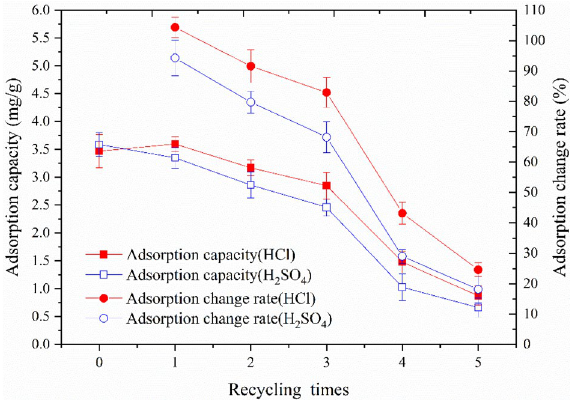
Figure 9. Adsorption effect under different regeneration